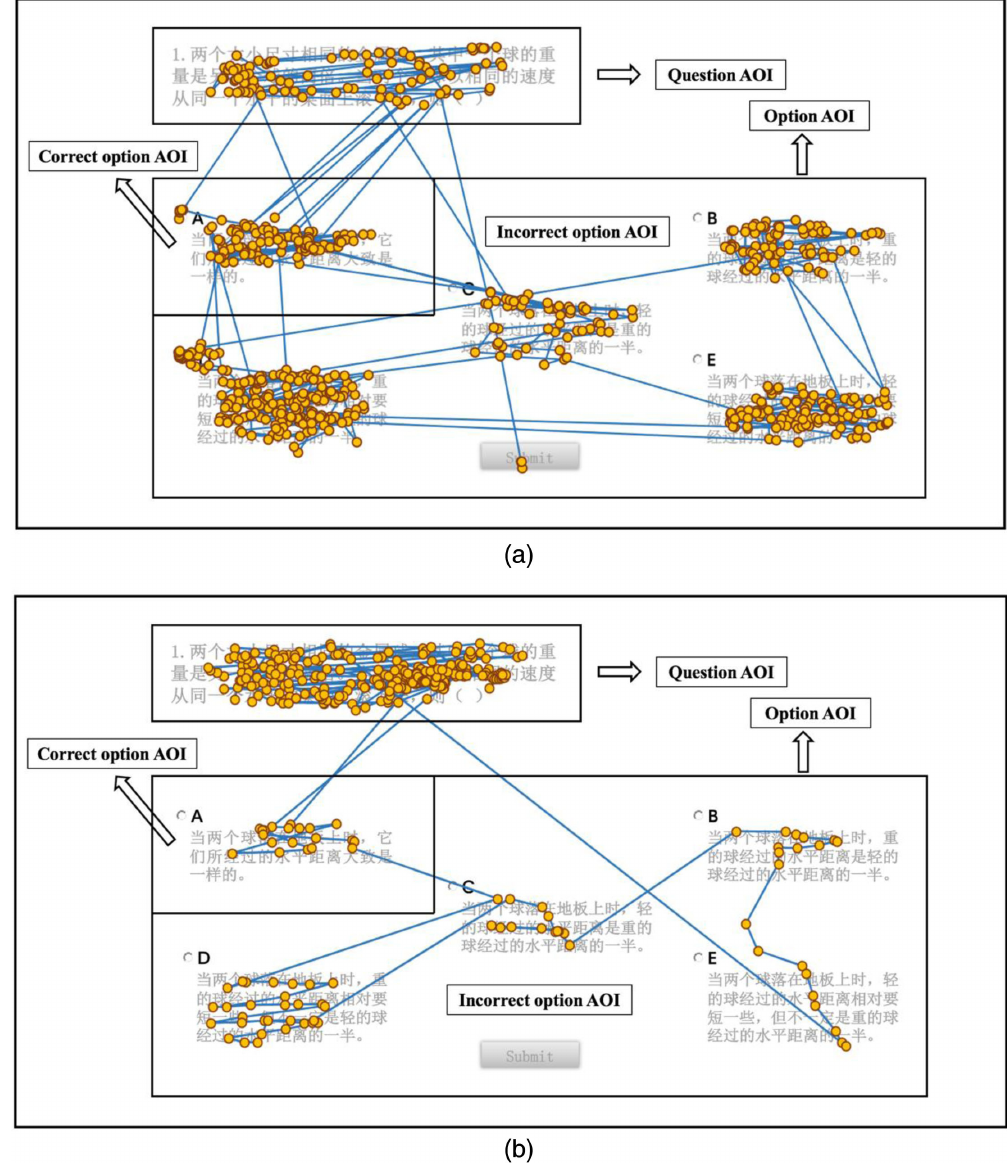
FIG. 2. (a) The scan path of participant A under prediction condition when solving item 1 (FCI question 2 [69]). (b) The scan path of participant B under the nonprediction condition when solving item 1 (FCI 2 question 2 [69]). Circles and solid lines represent the fixations and